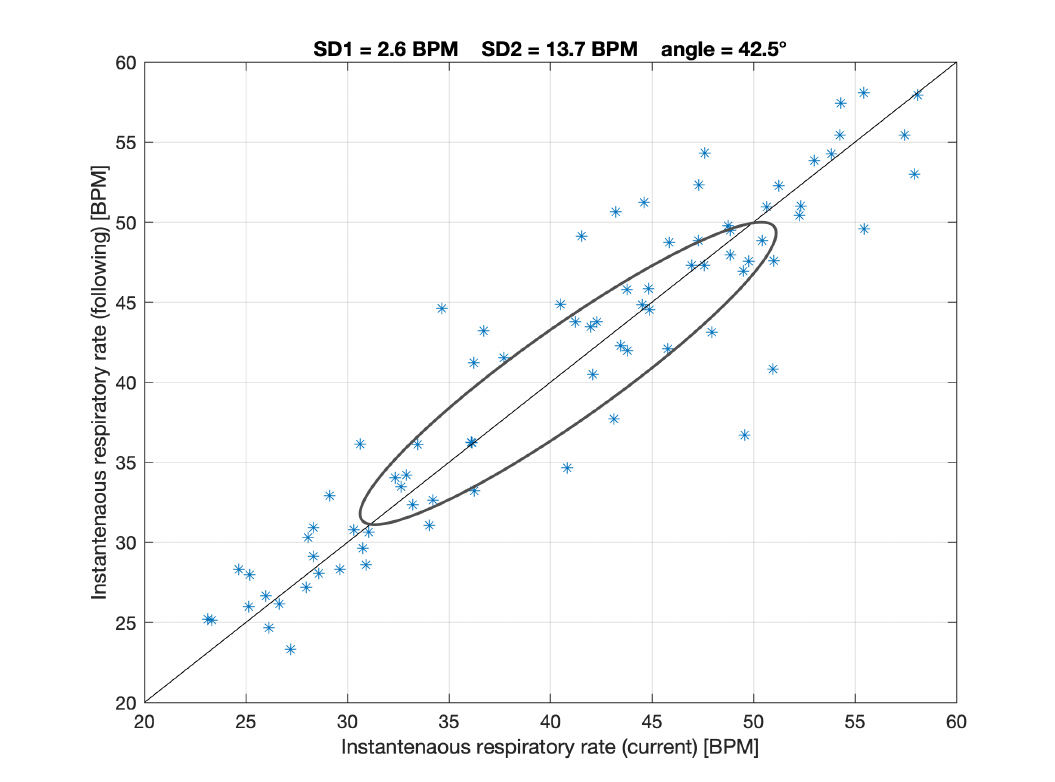
Figure 4. Sample figure presenting respiratory-related Poincare-plot equivalent for the respiratory rate case, for the 34th subject. Angle means the tilt of the ellipse fitted and is presented